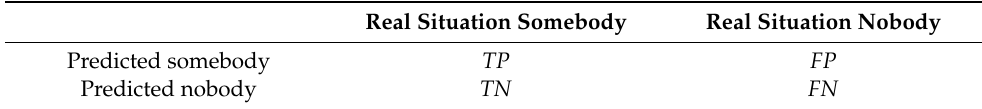
Table 4. Confusion matrix.